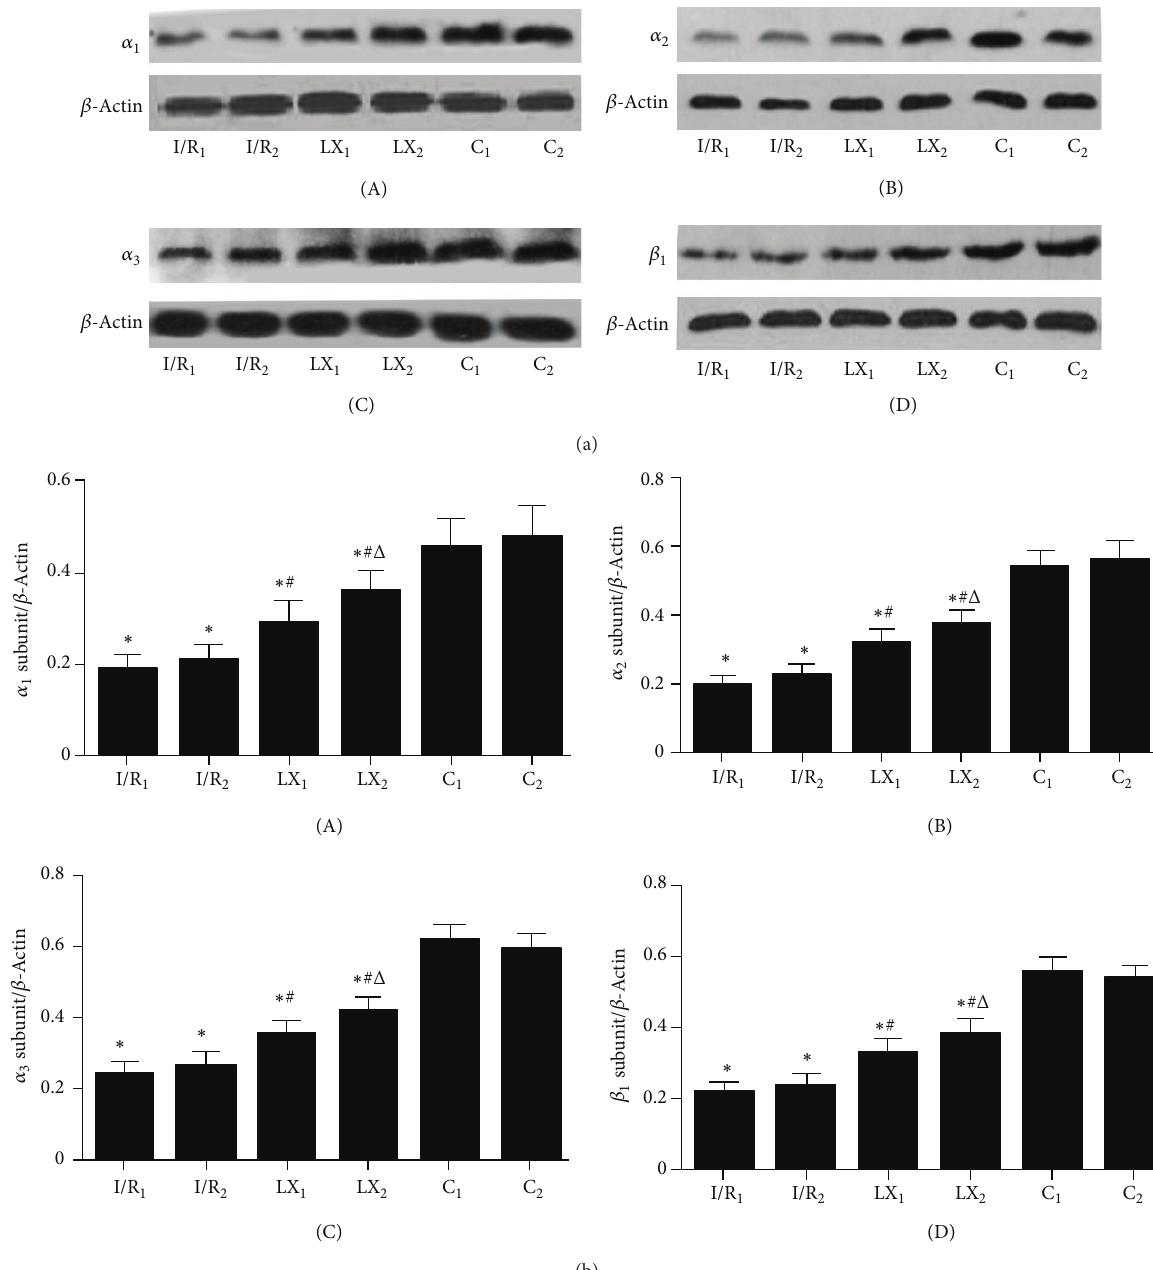
Figure 6: Protein levels of 𝛼 1 , 𝛼 2 , and 𝛼 3 and 𝛽 1 subunits of Na + -K + -ATPase of cardiac tissues from rats of different groups at T 2 . Samples were collected right after I/R procedure was over and western blot was performed as described in the section of Materials and Methods, and 𝛽 - Actin was used as a loading control. Representative blots of three independent experiments were shown. (a) Western blotting: (A) 𝛼 1 subunit of Na + -K + -ATPase; (B) 𝛼 2 subunit; (C) 𝛼 3 subunit; (D) 𝛽 1 subunit. (b) Quantitative data of western blot: (A) 𝛼 1 subunit of Na + -K + -ATPase; (B) 𝛼 2 subunit; (C) 𝛼 3 subunit; (D) 𝛽 1 subunit. ∗ 𝑃 < 0.05 for comparisons of I/R 1 and LX 1 groups with C 1 group, 𝑃 < 0.05 for comparisons of I/R 2 and LX 2 with C 2 group; # 𝑃 < 0.05 for comparisons of LX 1 group with I/R 1 group, 𝑃 < 0.05 for comparisons of LX 2 group with I/R 2 group; Δ 𝑃 < 0.05 for comparisons of LX 2 group with LX 1